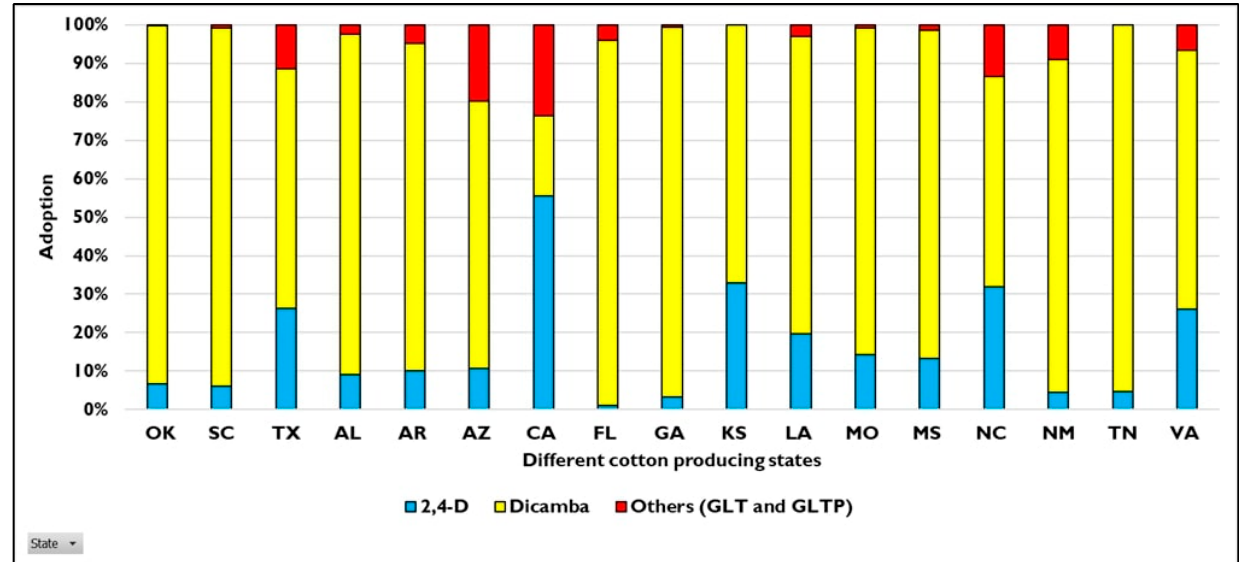
Figure 1. Adoption of genetically modified cotton in the U.S. during 2000–2020 [6].